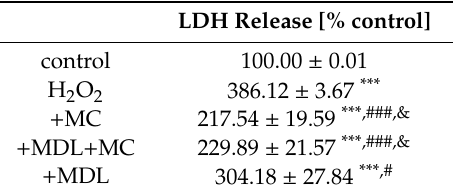
Table 1. The e ff ect of calpain inhibitor on the methyl ca ff eate-mediated protection against the hydrogen peroxide-induced cell damage in UN-SH-SY5Y cells.